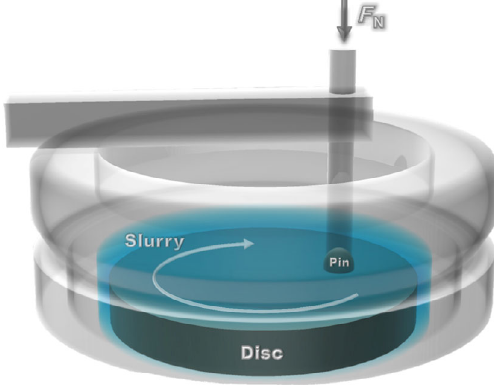
Fig. 2 Experimental set-up of the pin-on-disc tribometer.